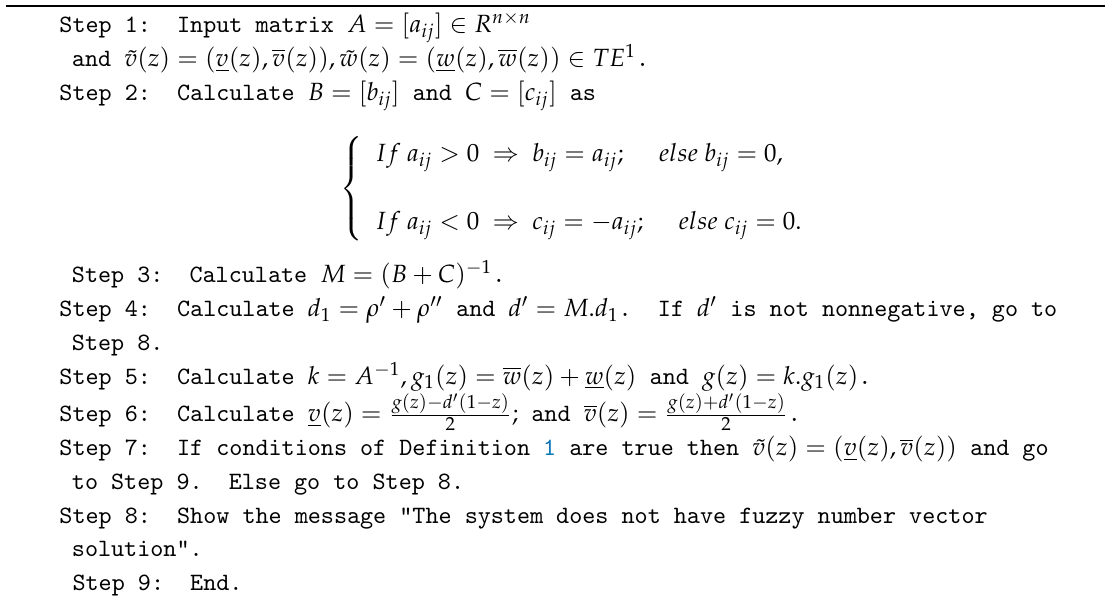
Algorithm 2: The following algorithm is presented to triangular fuzzy linear